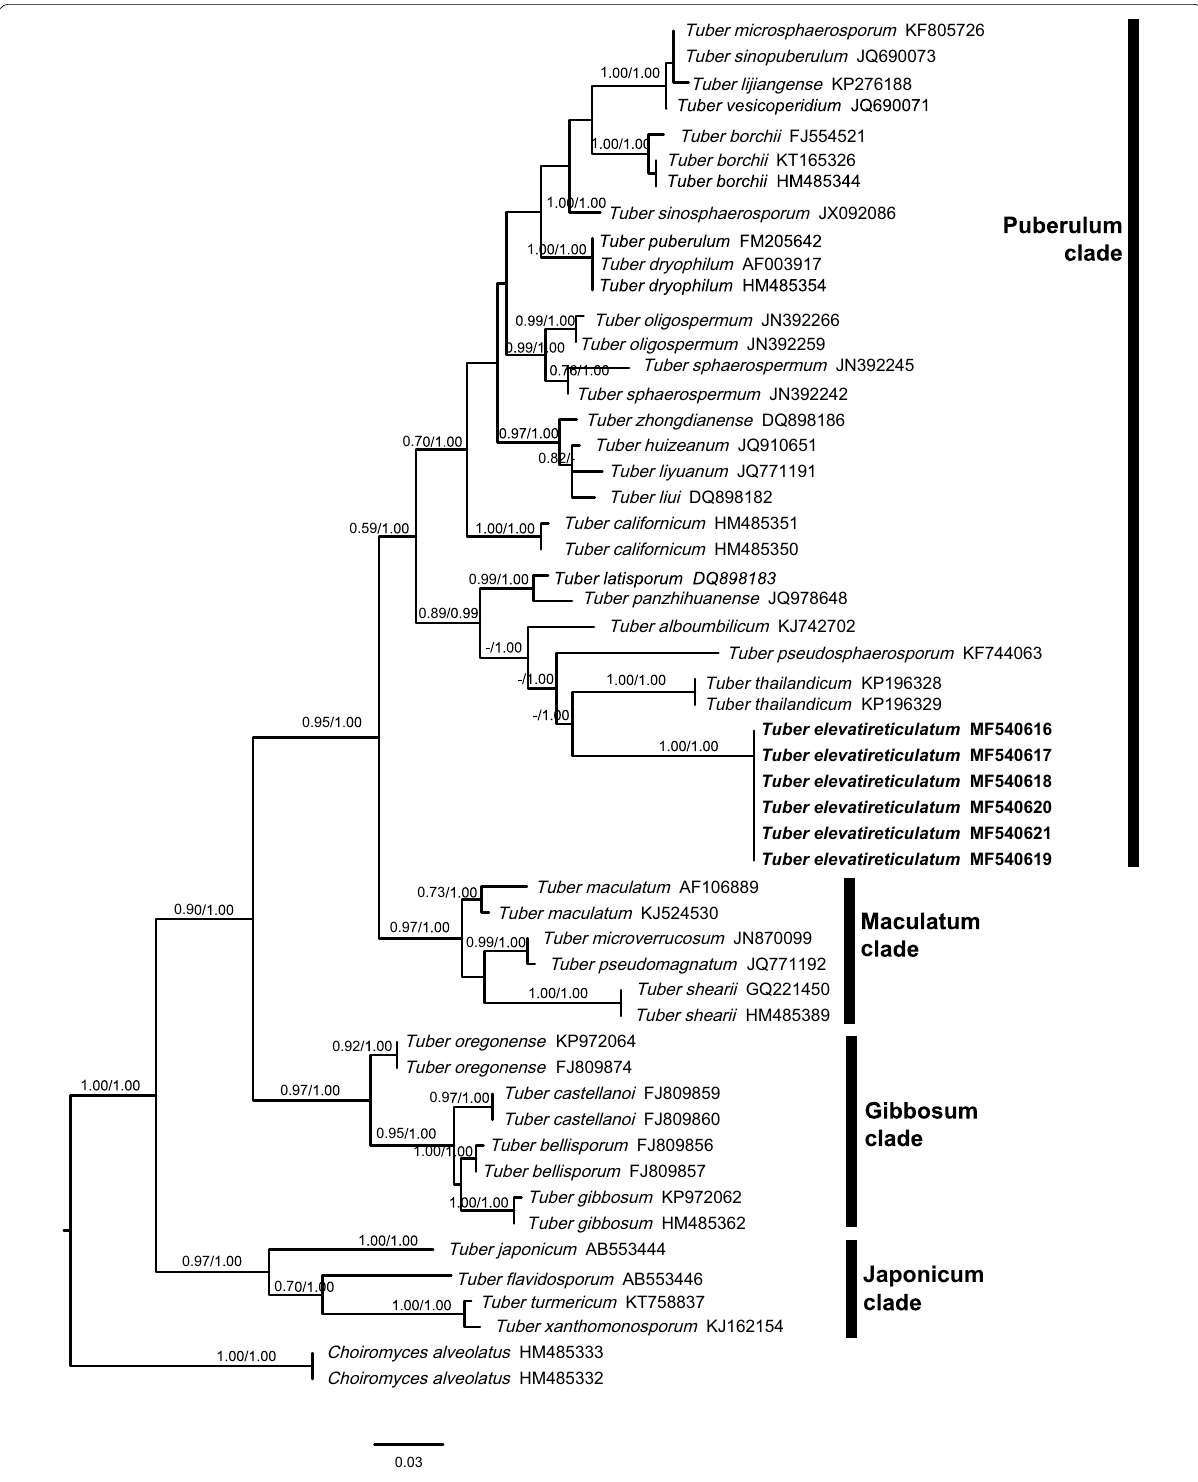
Fig. 2 Phylogenetic tree of Tuber elevatireticulatum and related whitish truffles based on the ITS‑rDNA sequences. Choiromyces alveolatus was used as the outgroup taxa. Numbers identify the bootstrap values and Bayesian posterior probabilities are indicated near branches as BS/PP. Values of BS and PP below 50% are not indicated. The sequences of new species described in this study are bold as